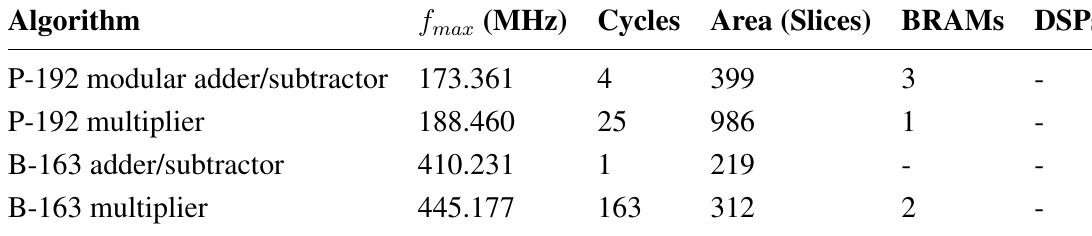
Table 3. Place and Route (PAR) results of the cryptographic algorithms implemented only using LUTs (XC7A100TL).